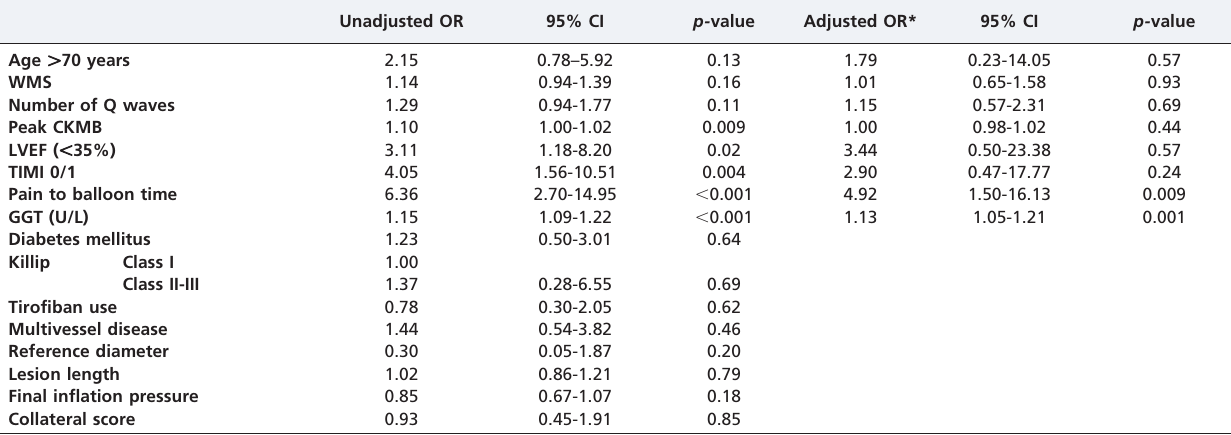
Table 4 - Effects of various variables on the myocardial perfusion grade assessed following primary percutaneous coronary intervention in univariate and multivariate logistic regression